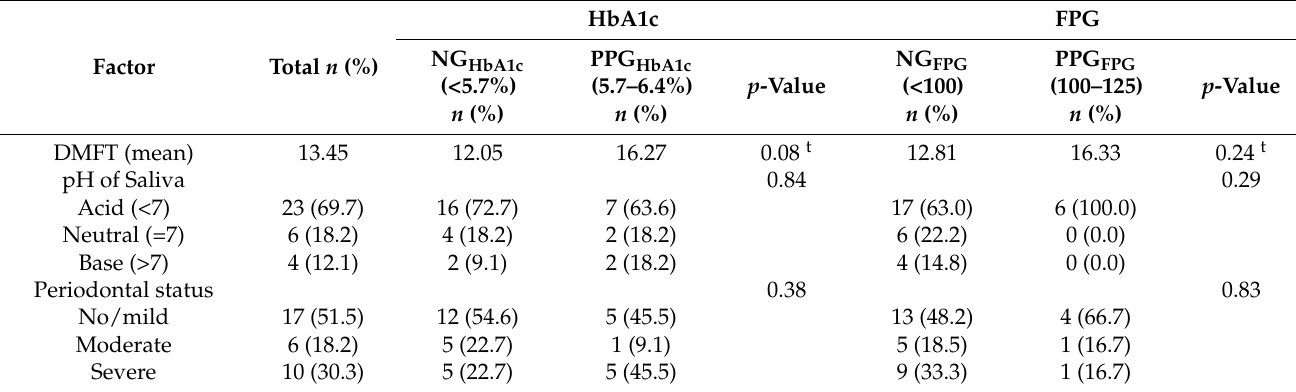
Table 2. Oral characteristics of 33 participants divided into NG and PPG groups according to either HbA1c or FPG